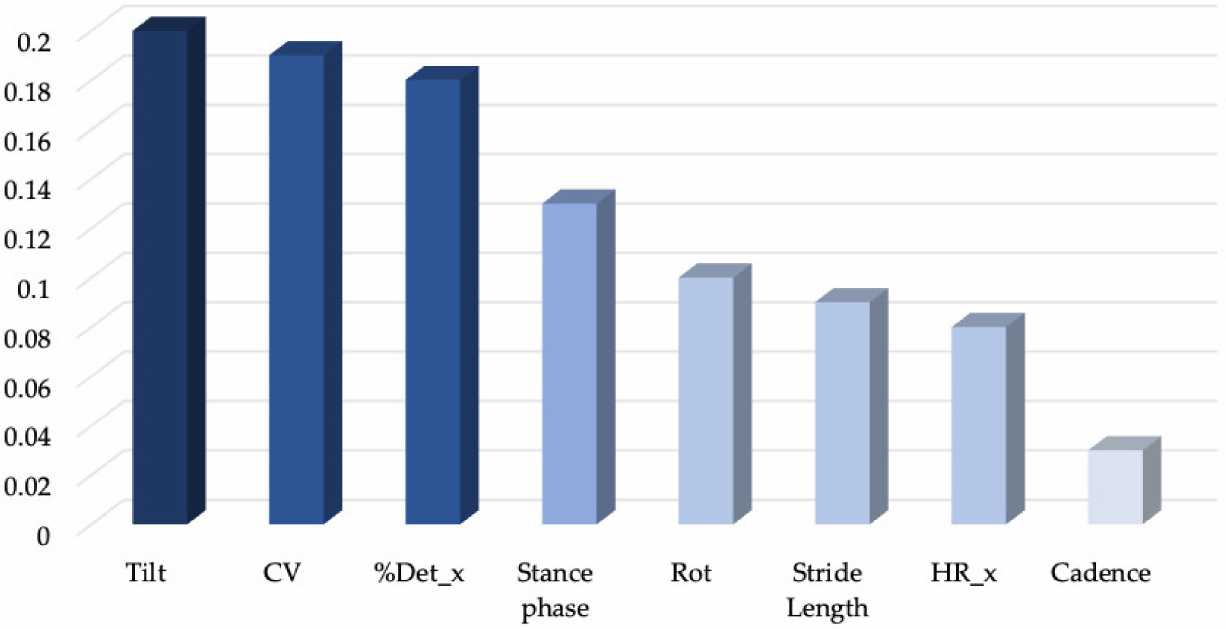
Figure 6. Random forest features importance. We analyzed features’ importance following implemen- tation of a random forest of 1000 trees. As we showed in the histogram plot, cadence was evaluated by the random forest algorithm as the less important characteristic of our dataset, confirming the SBS re- sult: HR_ap, harmonic ratio anteroposterior; RQAdet, % determinism in the recurrence quantification analysis anteroposterior; CV, coefficient of variation of the step